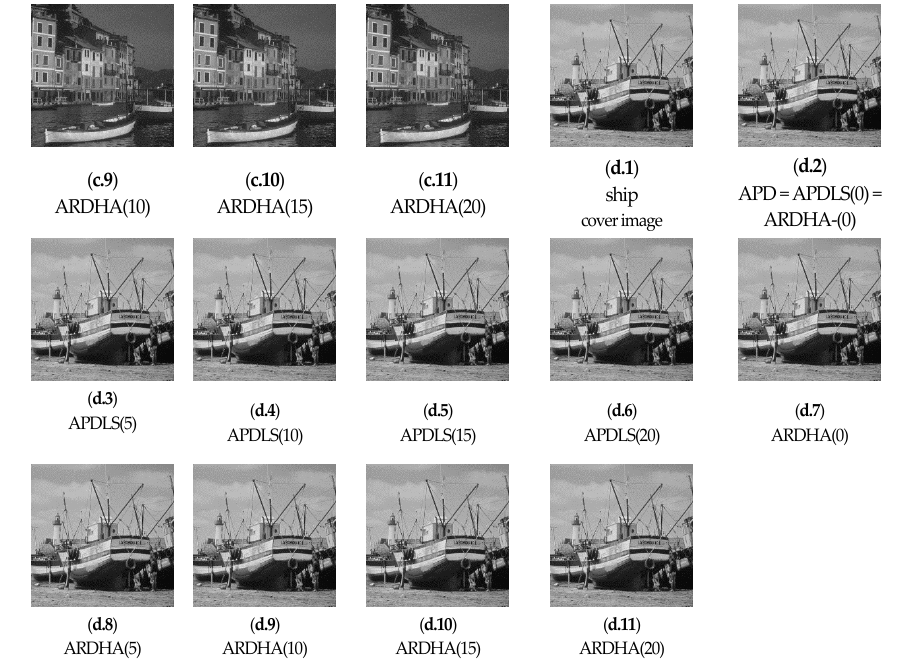
Figure 13. Cover images and stego-images.